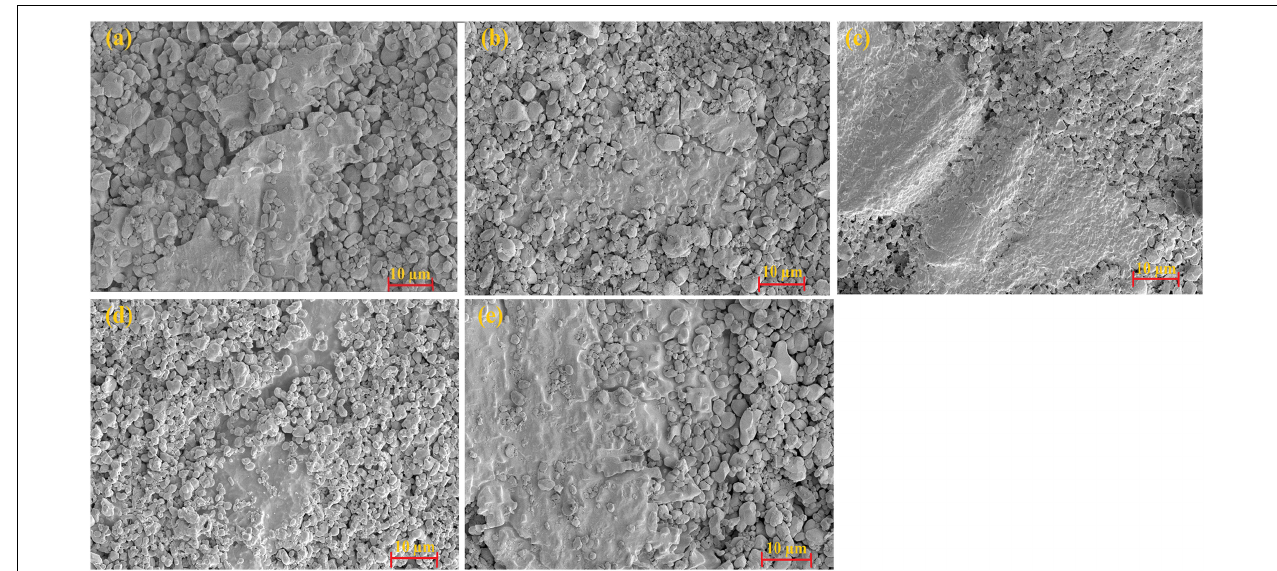
FIGURE 7 | Dependence of microstructure of 0.5NCMVO-0.5NaCl composite with sintering temperature (a) 140 ◦ C, (b) 160 ◦ C, (c) 180 ◦ C, (d) 200 ◦ C, and (e) 220 ◦ C.